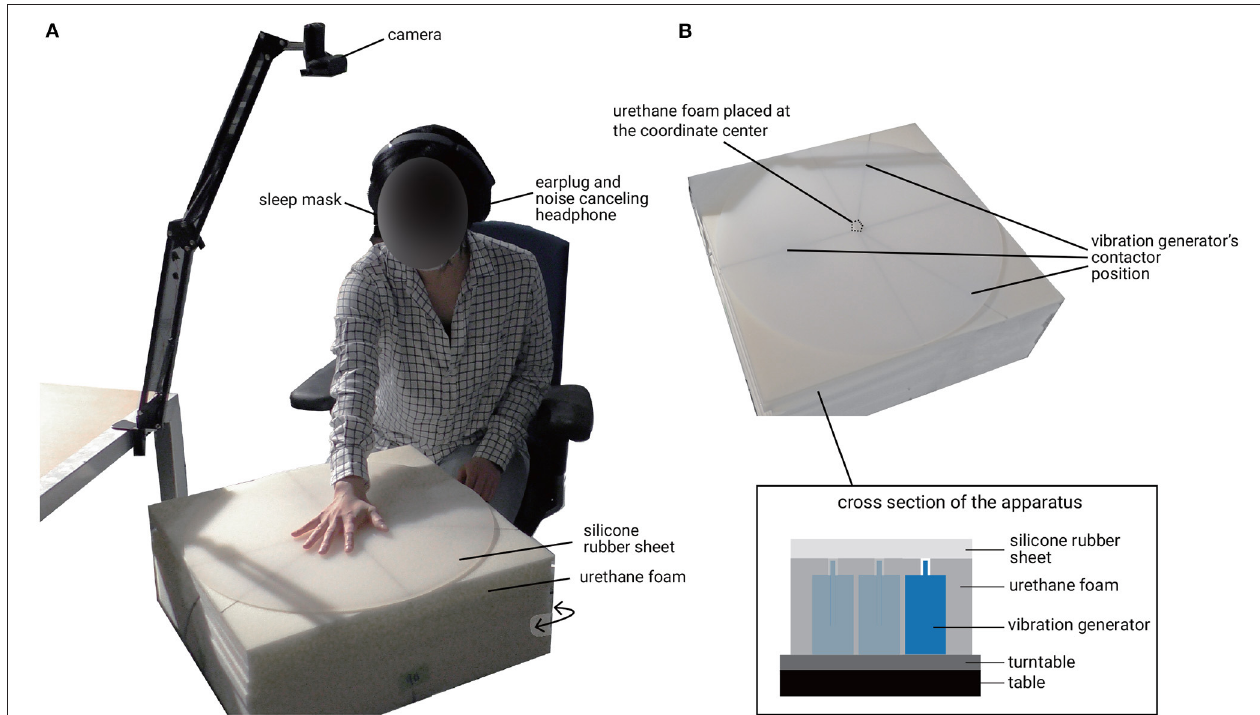
FIGURE 1 | Experimental environment. (A) Overview. (B)